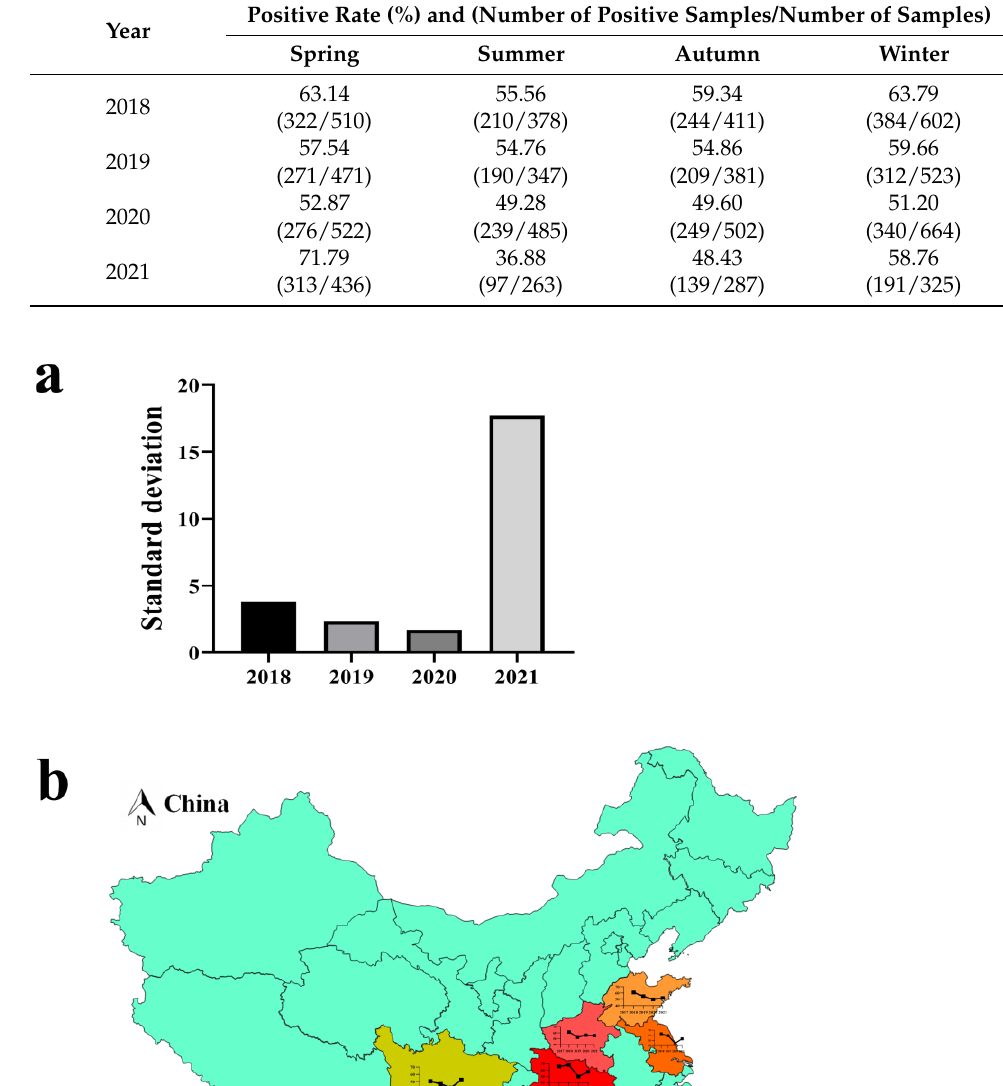
Table 5. Positive rates of swine enteric virus from 2018 to 2021.